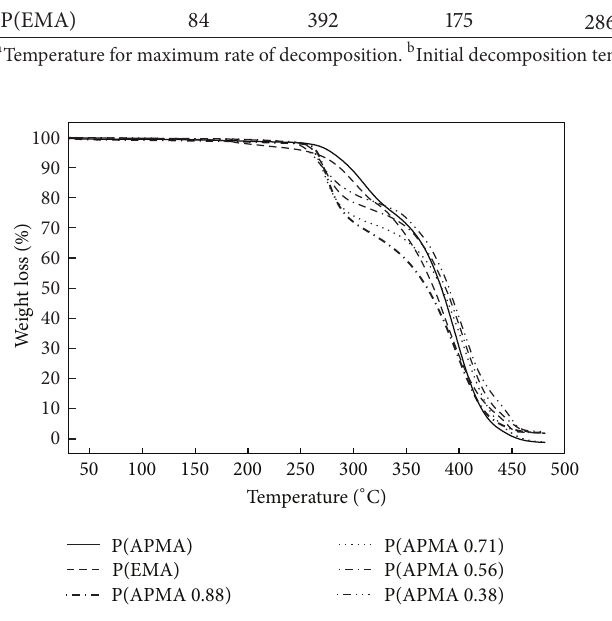
Figure 7: Thermal degradation curves of homo- and copolymers.